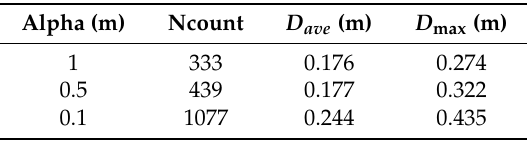
Table 10. Accuracy comparison of three different alpha values.